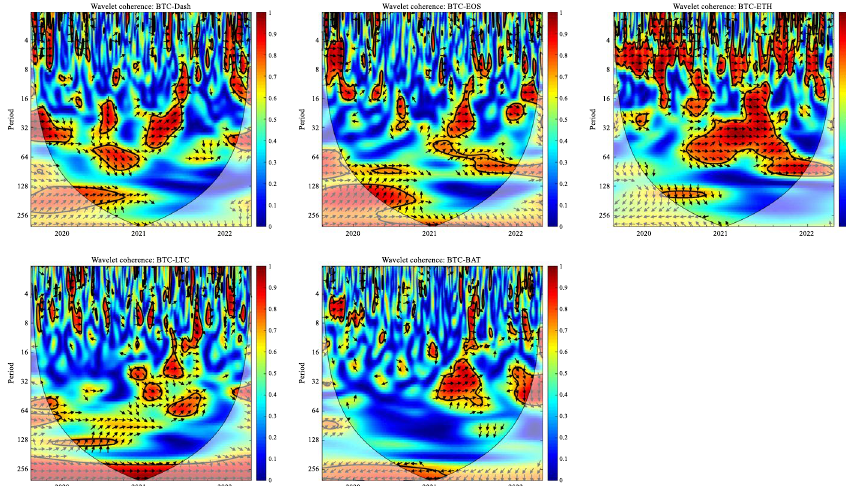
Fig. 5 Wavelet coherence—realized kurtosis (RK)